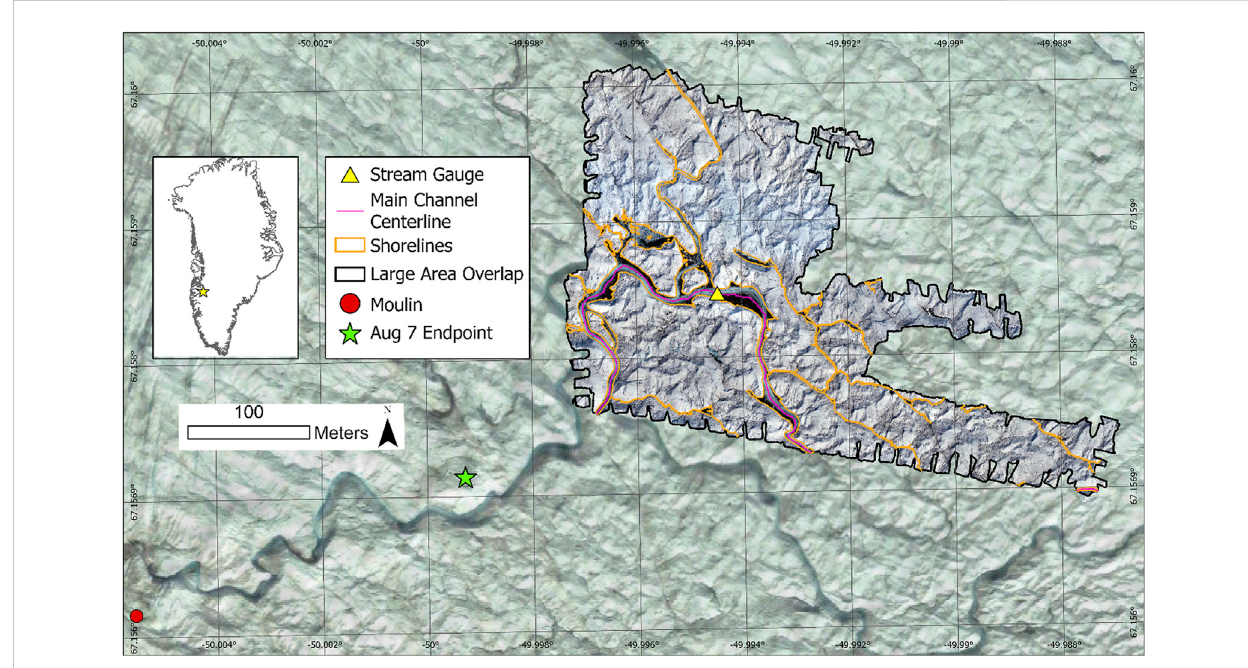
FIGURE 1 Map of the study site with UAV imagery from 22 July 2019 clipped to the large area overlap footprint. Orange lines show the location of manually digitized shorelines and the pink line indicates the centerline of the main channel. The location of the stream gauge used to measure water depth throughout the observation period, the furthest downstream location of theAugust 7th observed main channel, and the moulin for the main channel are shown as a yellow triangle, a green star, and a red circle respectively. The inset map shows the location of the fi eld site in southwestern Greenland. Background imagery is a Maxar Technologies image obtained from Google Earth collected on July 24, 2012 overlain on the ArcticDEM (Polar Geospatial Centeretal.,2018).Becausethetimeoffsetbetweenthebackgroundimage(2012)andthedatacollection(2019),themovementoftheicehasshiftedthe channel location and the Aug 7 Endpoint and moulin are outside the 2012 channel.